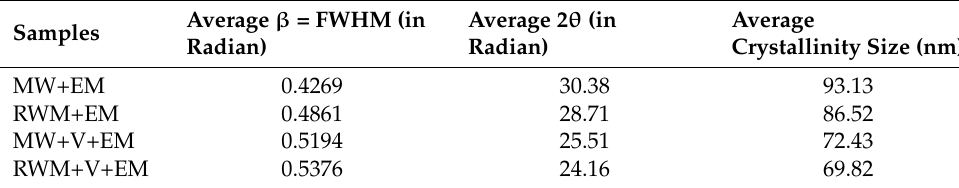
Table 3. Seven averages of the cellulose peaks used to calculate the crystallinity size.